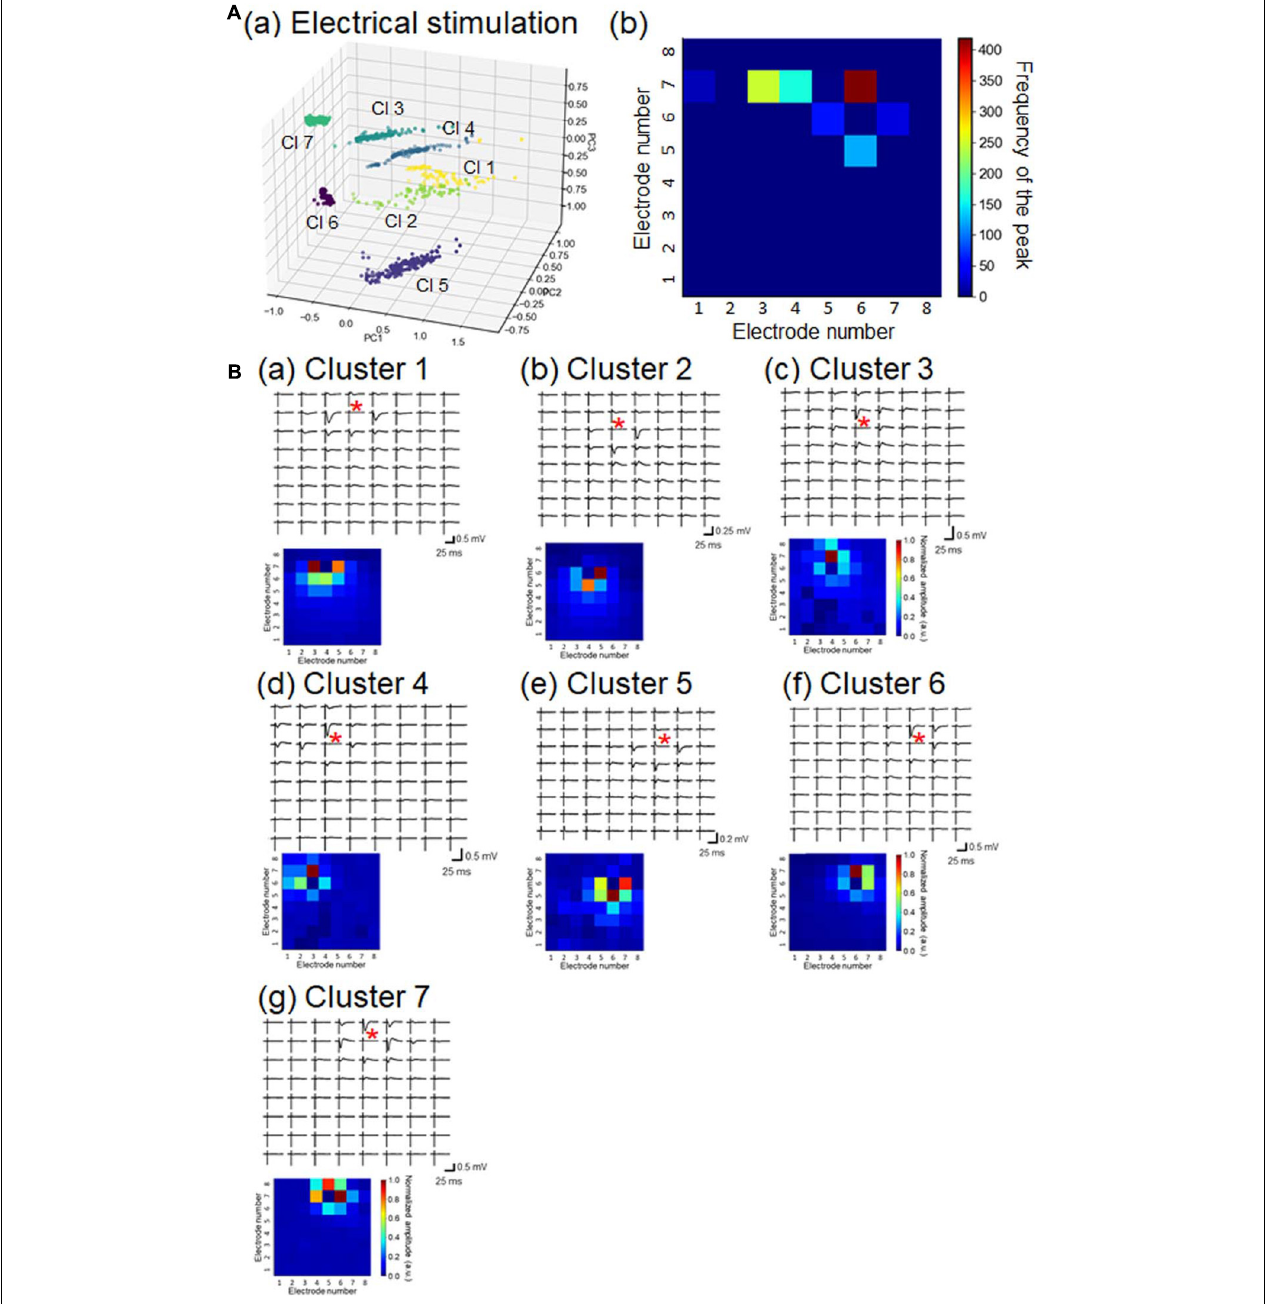
FIGURE 7 | Properties of LFP response patterns for current stimulation and pattern classification. (A) A total of 1,069 LFP patterns were converted into pattern vectors a p . The vectors were plotted in 3D space for three major components, calculated using standard principal component analysis (PCA), shown in (a). The vectors are classified into seven clusters (Cls): Cls 1 to 7. In (b), for each response pattern, the number of sites for which the maximum amplitude was at a negative peak was counted and accumulated on a 2D electrode array. The colormap shows the frequency of the maximum amplitude sites among the 64 electrode sites. (B) For each cluster, a typical LFP response (upper) and associated pattern matrix (lower) with elements that represent the peak amplitudes. Each stimulation site is indicated by a red asterisk in each LFP response